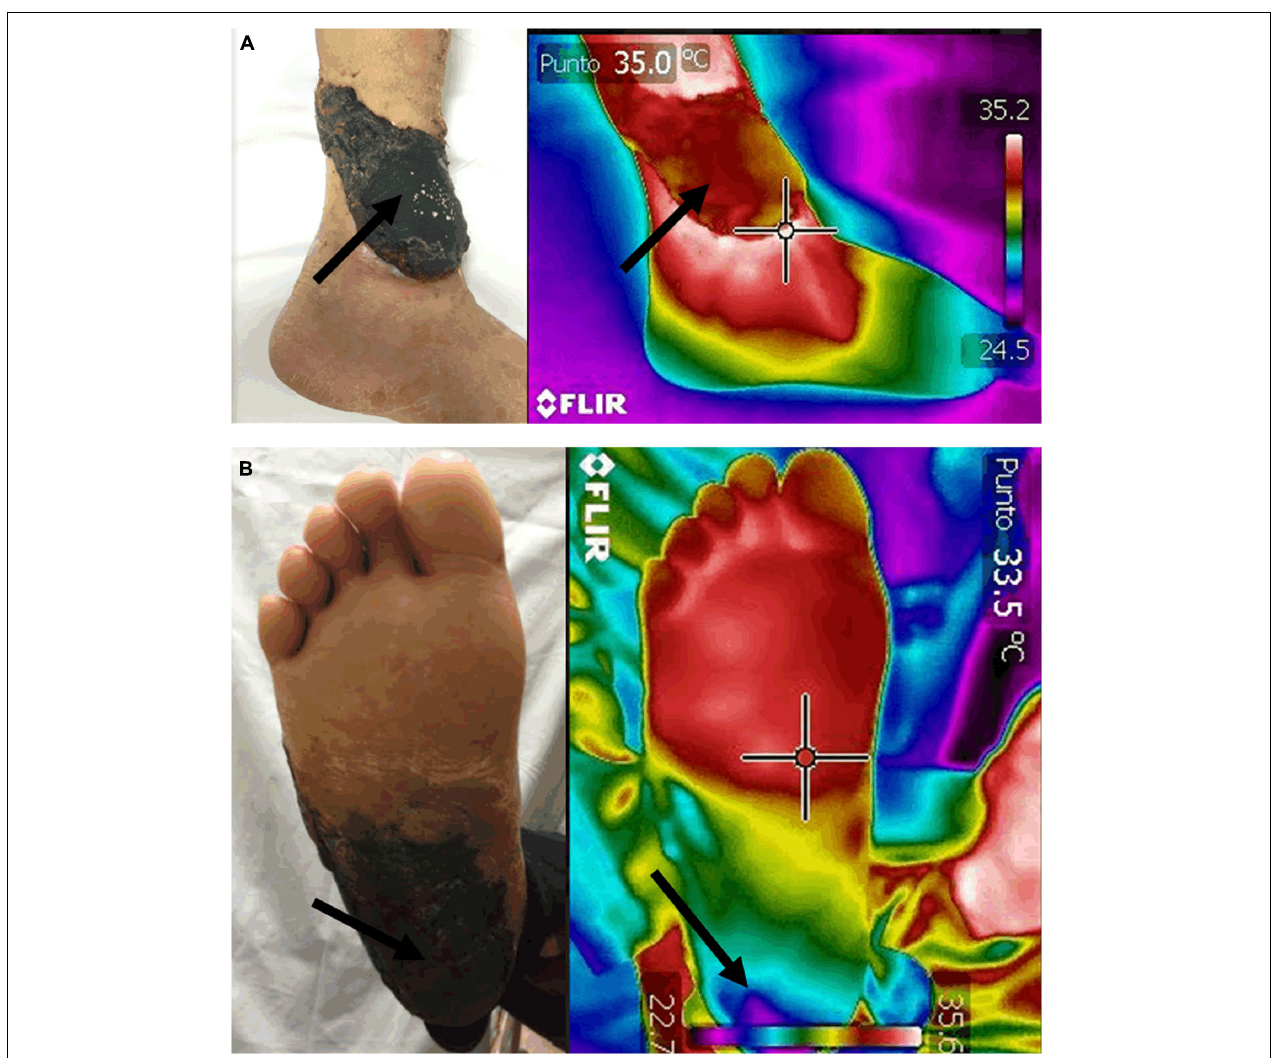
FIGURE 9 | Assessment of free flap survival. Infrared thermography was used to assess survival of free tissue flaps (arrows) 2-weeks post-surgery. Restoration of the initial negative temperature gradient between uninjured tissue and the flap has been found to be highly predictive of flap perfusion and survival (A) . In contrast, failing flaps show coldspots that represent areas of malperfusion (B) . Interestingly, despite the clinical images of both patients showing dermal necrosis of the flaps, the thermal images show striking differences in tissue perfusion. Images, courtesy of Dr. Mario A. Martinez-Jimenez, were acquired using a FLIR One Pro mobile